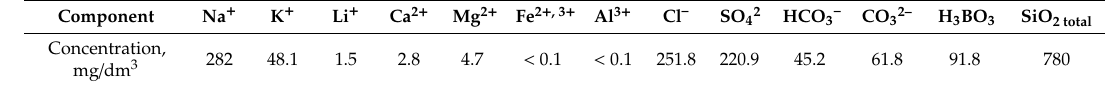
Table 1. The concentration of the main components of the initial hydrothermal solution. Component Na + K + Li + Ca 2 + Mg 2 + Fe 2 + ,3 + Al 3 + Cl – SO 42 HCO 3– CO 32– H 3 BO 3 SiO 2total Concentration, 282 mg / dm 3